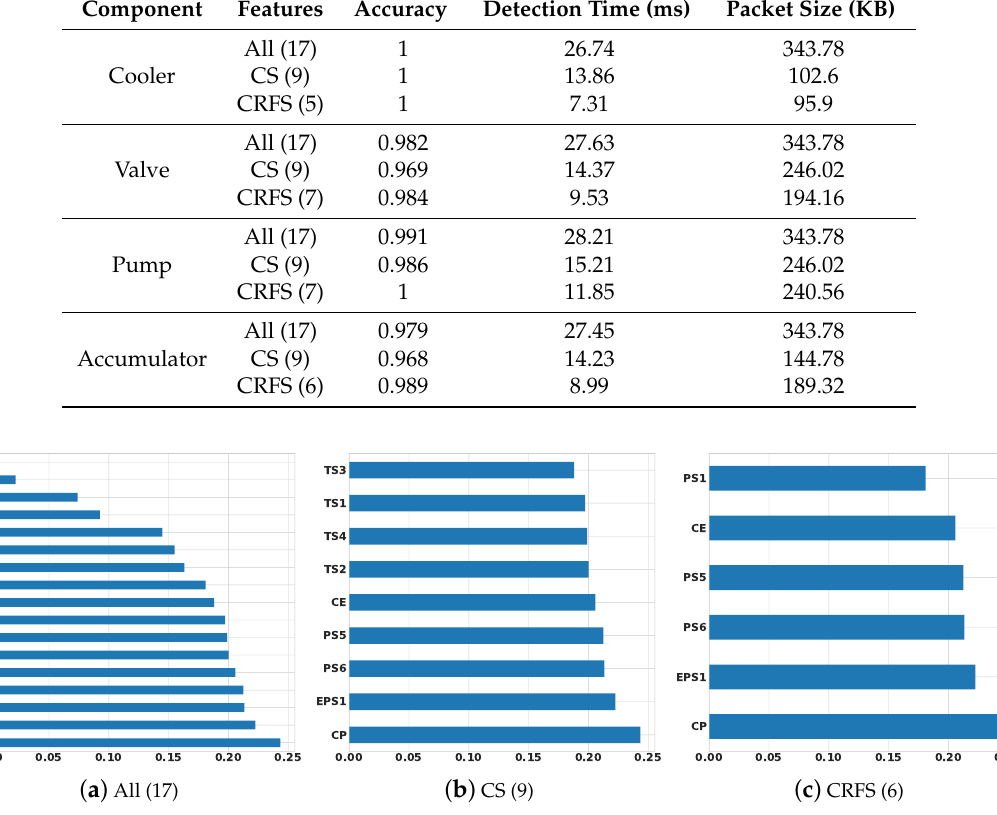
Figure 8. Feature-to-label correlation on Accumulator fault label. Higher value represents more importance.